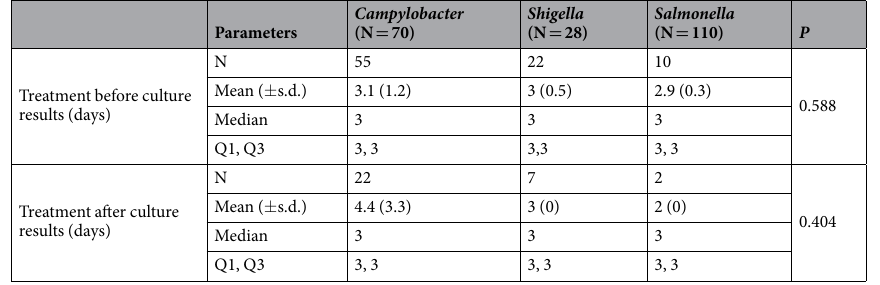
Table 4. Days of antibiotic treatment before and after culture results in the three groups. This table includes information concerning patients in the three pathogen groups, which was obtained from their medical charts.